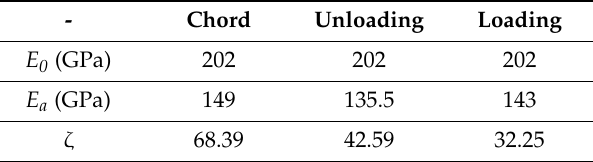
Table 1. Yoshida equation’s parameters for st-37.